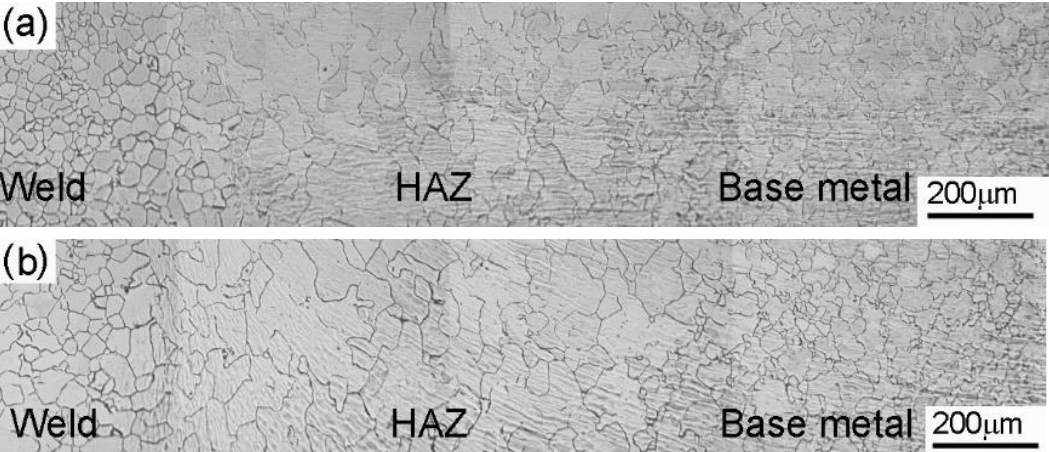
Figure 4. Optical micrograph of weldments; ( a ) as-welded condition; and ( b ) PWHT condition.